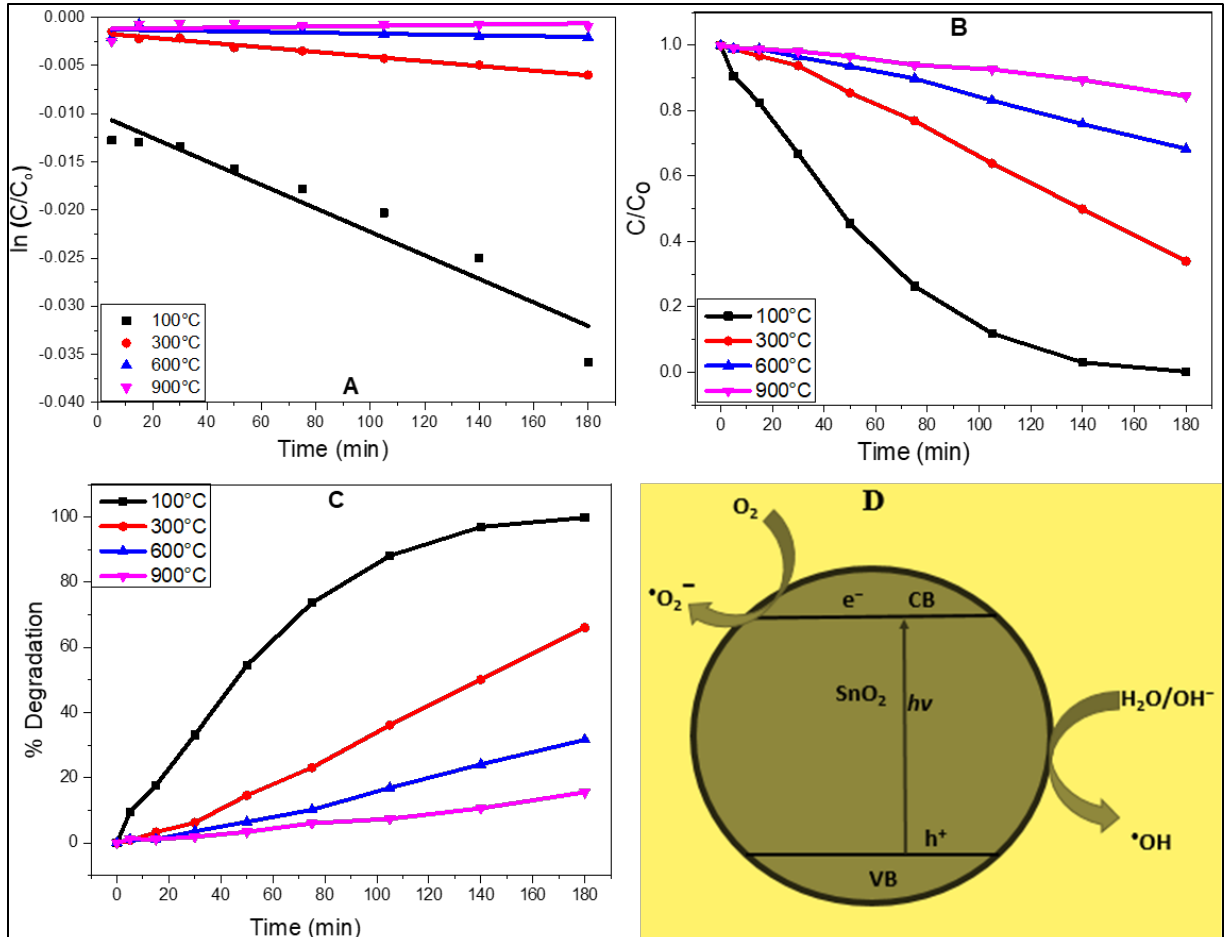
Figure 7. Percentage degradation, kinetic rate constant ( A – C ), and schematic mechanism of photodegradation reaction ( D ).